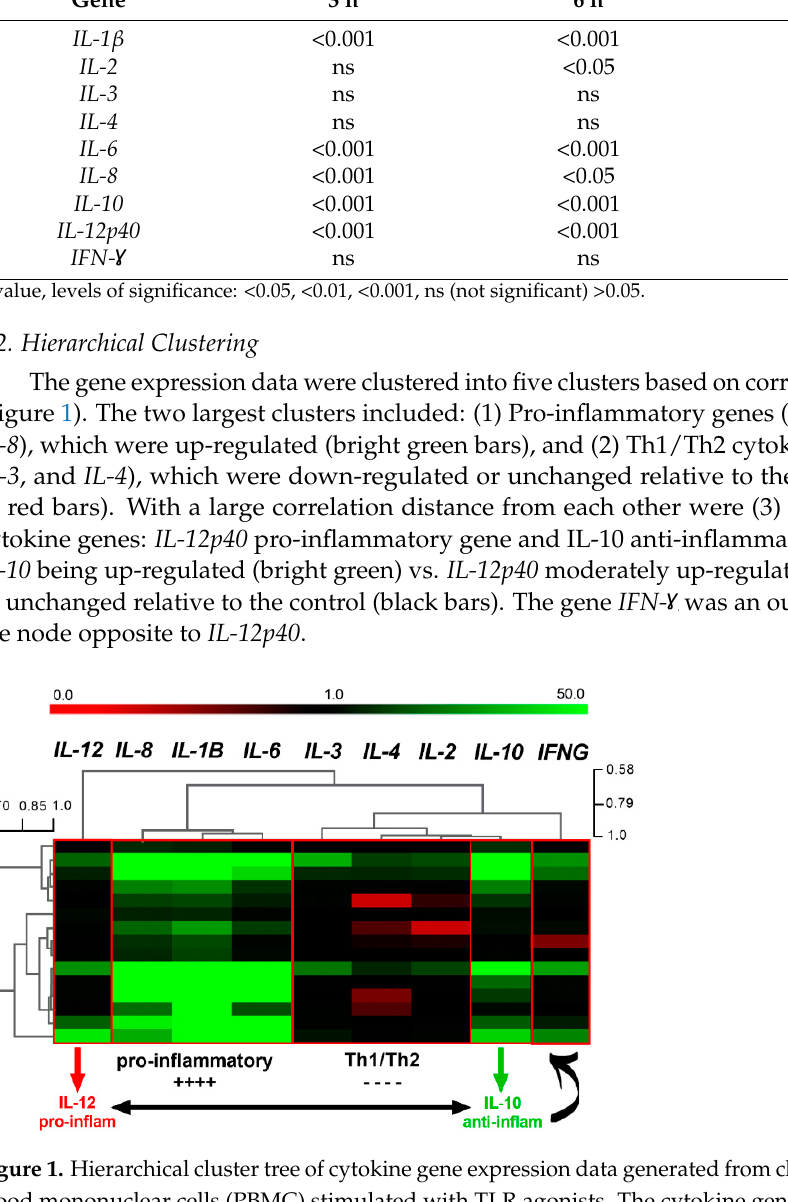
Table 3. Results of variance analysis (one-way ANOVA) at different time-points post-stimulation. Gene